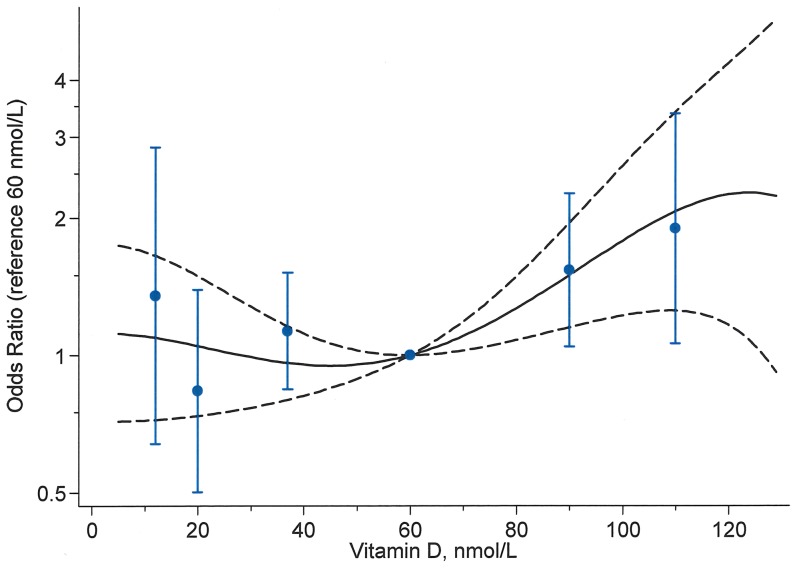
Association between postpartum depression and vitamin D.The fitted fractional polynomial model of degree 3 (FP (3)) with 95% CI in black and the categorical estimates in blue. The odds ratios are from the fully adjusted model adjusting for maternal age, year of delivery, season, gestation week, parity, smoking, socio economic status, BMI group, physical activity and social support and multivitamin supplement. The reference concentration is 60 nmol/L. The fractional polynomial part of the final model is estimated to be: log Odds =  constant+0.46·X3+0.27·X3·ln(X) -3.26·X3·ln(X)2, where X = vitamin D/100.